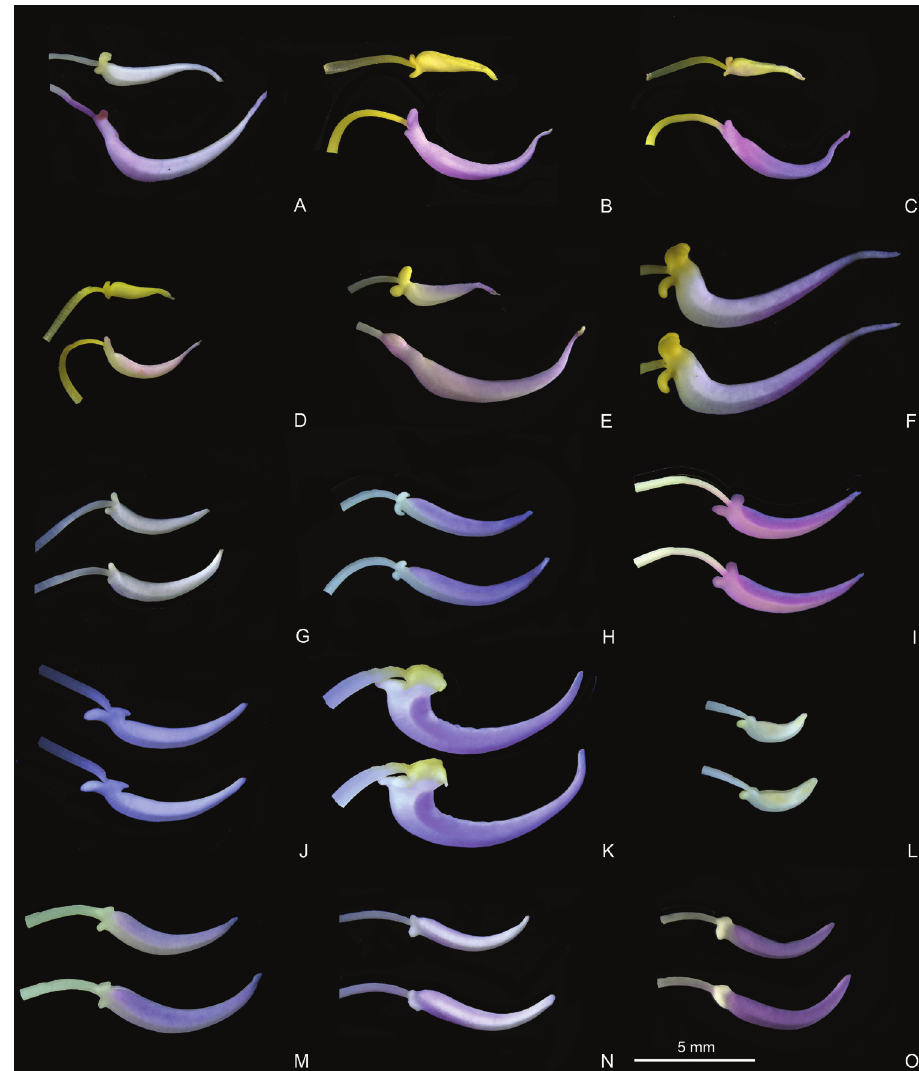
Figure 7. Stamen morphology in the Bredia clade. A–E Dimorphic stamens: A B. esquirolii ( Y. Liu 587 ) B B. hirsuta ( Y. Liu 563 ) C B. hirsuta var. scandens ( Y. Liu 539 ) D B. rotundifolia ( Y. Liu 538 ) E B. tuber- culata ( Y. Liu 629 ). F–O Isomorphic stamens: F B. fordii ( Y. Liu 444 ) G B. fordii var. micrantha ( Y. Liu 580 ) H B. gracilis ( Y. Liu 457 ) I B. guidongensis ( Y. Liu 472 ) J B. longearistata ( Y. Liu 496 ) K B. longiradiosa var. pulchella ( Y. Liu 485 ) L B. microphylla ( Y. Liu 551 ) M B. plagiopetala ( Y. Liu 460 ) N B. repens ( Y. Liu 558 ) O B. yunnanensis ( Y. Liu 627 ). Scale bar: 5